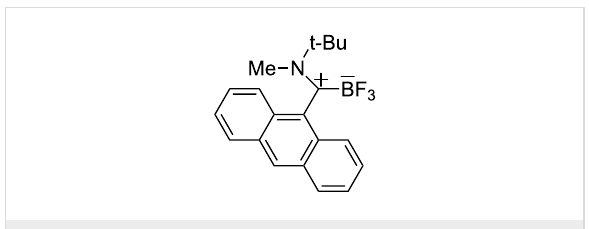
Figure 2: Bertrand’s amino anthracenyl carbene trifluoroborane com-